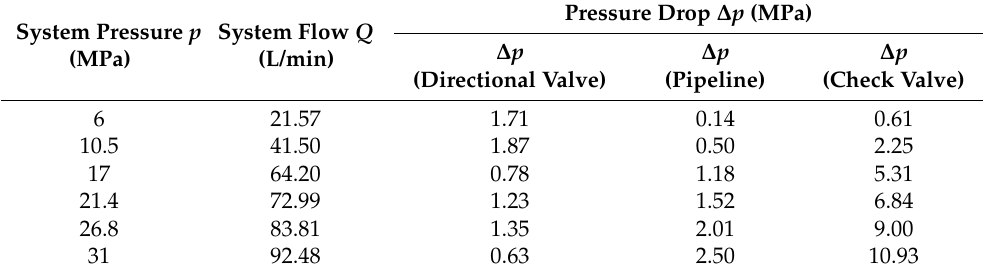
Table 3. Hydraulic cylinder retraction data under DN10 pipeline diameter.